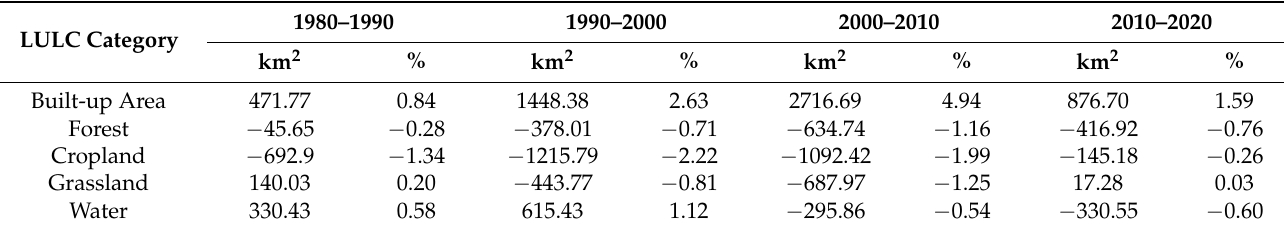
Figure 5. LULC transition from 1980–2020 ( a ) transition to built-up land, ( b ) transition to forest, ( c ) transition to cropland, ( d ) transition to grassland, and ( e ) transition to water. Table 4. Temporal changes in 1980–2020.